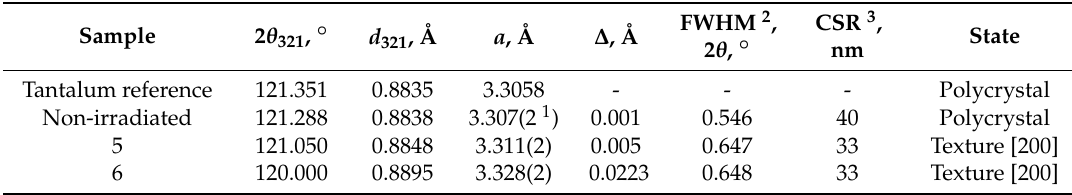
Table 1. Sample powder X-ray diffraction characteristics.